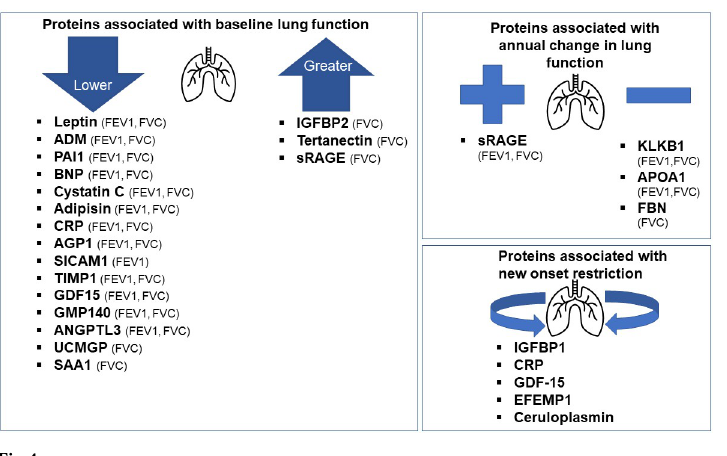
inflammation leading to endothelial dysfunction, tissue dysregulation, and impaired vascular response [20]. While associations between CVD and pulmonary diseases have been well estab- lished, there is growing evidence that subtle changes in spirometry indices of lung function, even within the normal range, are predictive of risk for future cardiac disease [21]. In particu- lar, reductions in FEV and FVC with a preserved FEV /FVC (consistent with restrictive lung 1 1 changes) in a young ostensibly healthy cohort was reported to be associated with adverse car- diac remodeling, increased left ventricular wall thickness, left ventricular mass, and increased odds of diastolic dysfunction [21, 22]. The association of FVC with increased CVD risk has